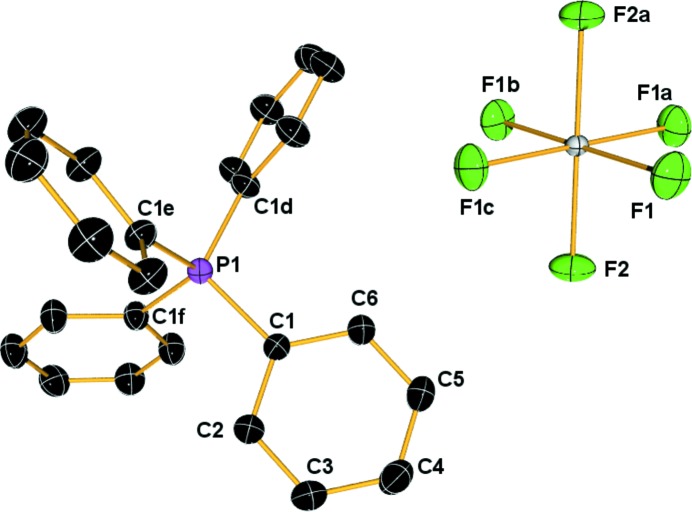

ORTEP plot of [PPh­4][UF6] with ellipsoids at the 99% probability level, H atoms have been omitted for clarity. Symmetry operators: a = y, 1 − x, 1 − z; b = 1 − x, 1 − y, z; c = 1 − y, x, − z; d = −0.5 + y, 0.5 − x, 0.5 − z; e = 0.5 − y, 0.5 + x, −0.5 − z; f = − x, 1 − y, z.